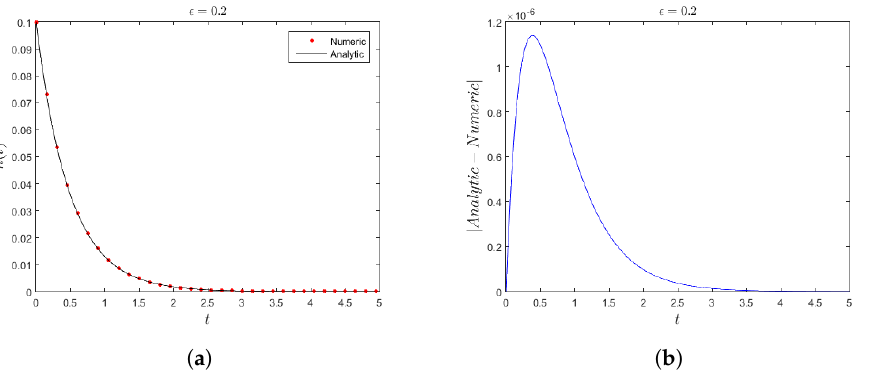
Figure 2. ( a ) The population evolution is extinct at a finite time. The solid curve represents the analytic solution, given by (24), while the dotted curve represents the numerical solution, generated using the fourth-order Runge-Kutta technique. ( b ) The absolute difference between the numerical and analytic solution of (24), where κ = 1 + 0.1sin ( (cid:101) t ) , ρ = 1 + 0.5sin ( (cid:101) t ) , η = 1 + 0.17sin ( (cid:101) t ) , µ = 0.1, and σ = 3.